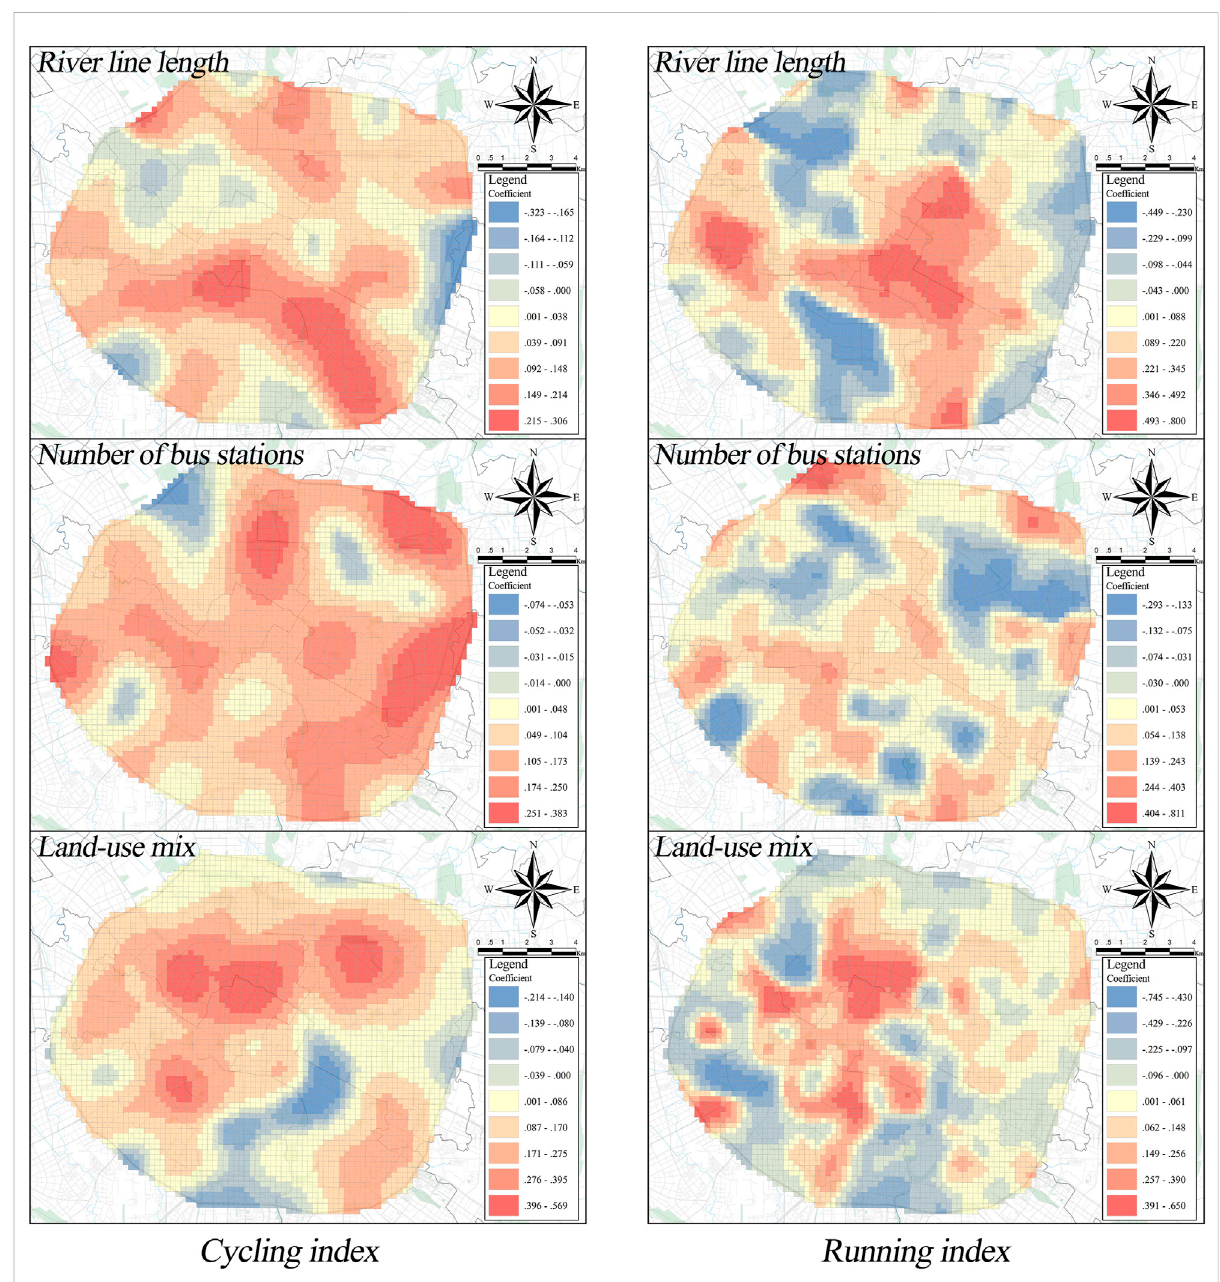
FIGURE 10 The spatial distribution of the coef fi cient of river line length, the number of bus stations, and land-use mix in the GWR